Question: Give a one-sentence summary of this figure.
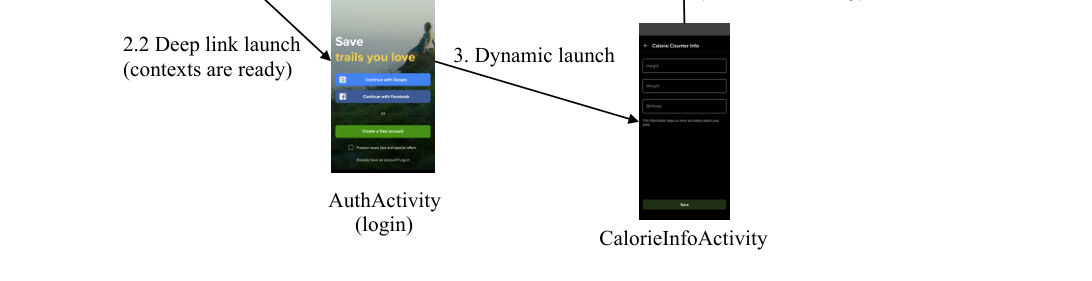
Answer: A concrete example of the enhancement exploration process in the app ‘Alltrails’.